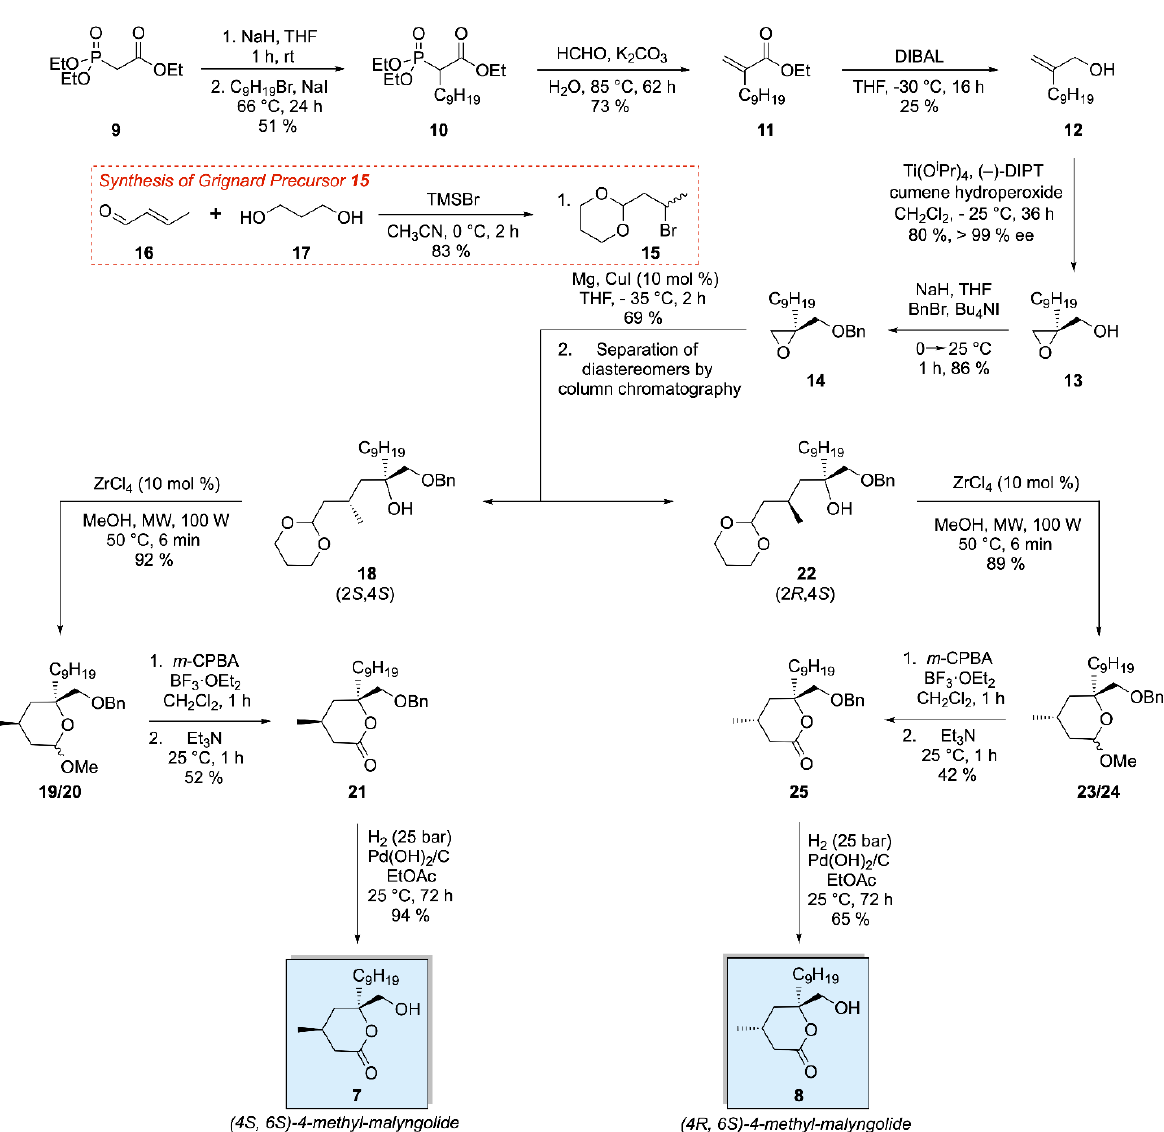
Table 2. The MIC and MBC measurements for compounds 7 – 8 .